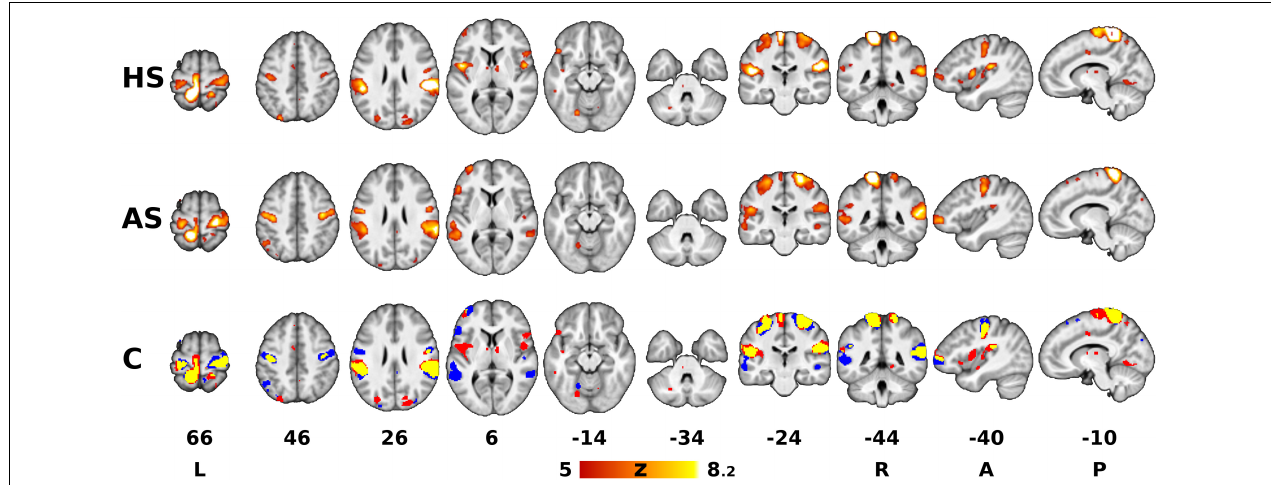
FIGURE 1 | Areas associated with sustained pressure stimulation. The red-yellow Z statistical overlays in the top and middle rows represent significant F -tests of mean response to heel stimulation (HS) and ankle stimulation (AS). The bottom row shows the binary conjunction (C) of HS and AS (red = heel, blue = ankle, yellow = conjunction of both). The images were superimposed on top of a gray-scale mean T 1 -weighted background image. Clusters of activation were determined by Z > 5 and thresholded at corrected p < 0.05. The slices are numbered according to coordinates in the Montreal Neurological Institute (MNI) 152 standard space template. The right is right, according to neurological